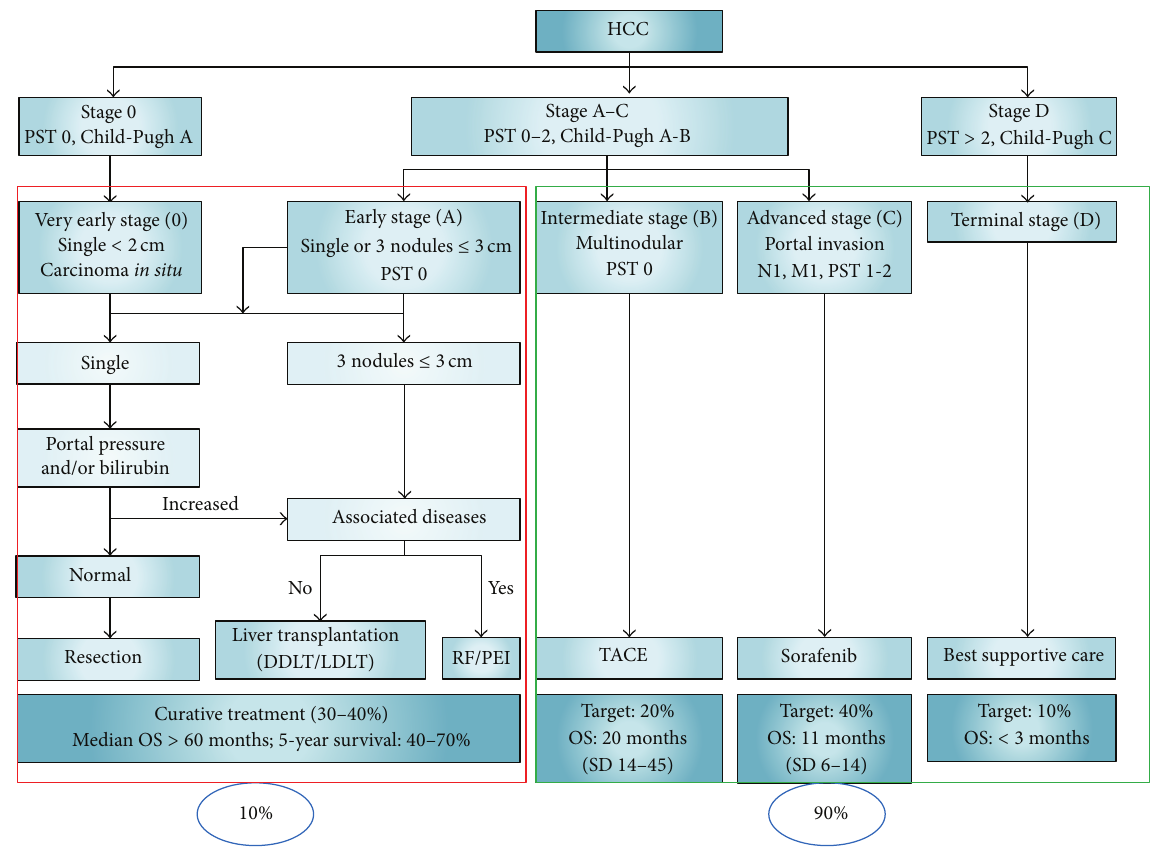
Figure 4: BCLC staging and relative distribution of Pakistani patients at the time of presentation. (Adapted from